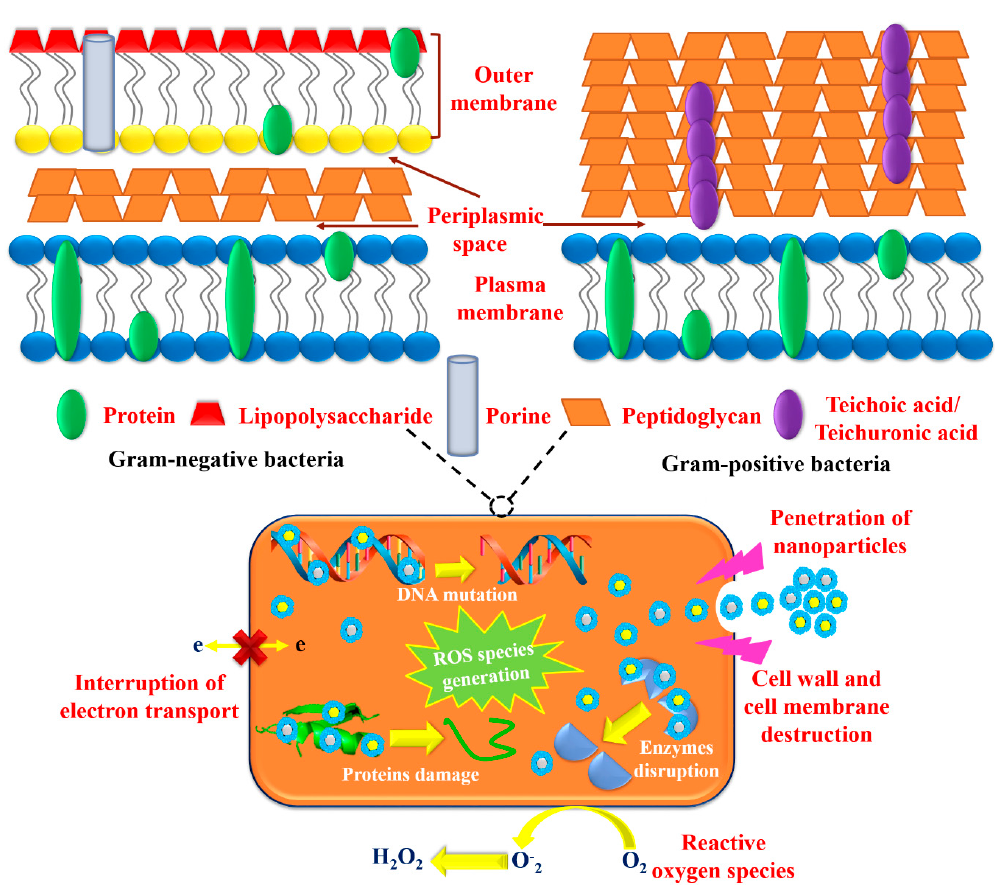
Figure 16. Cell wall comparison of Gram-positive and Gram-negative bacteriological strains.